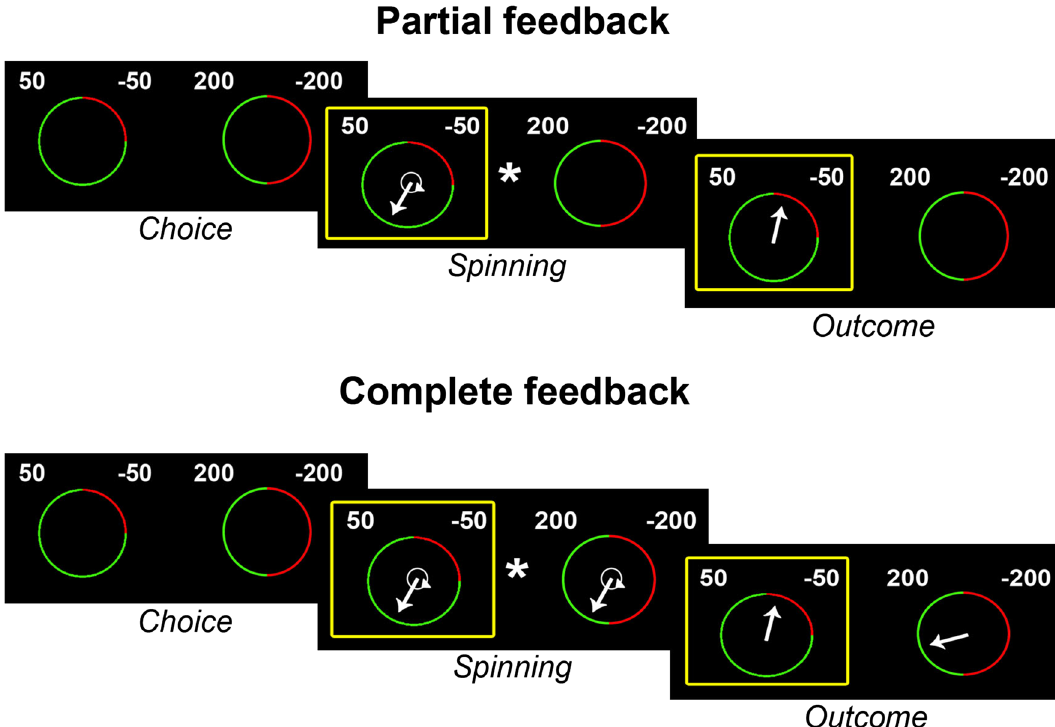
Figure 2. Wheel of fortune (WoF) task. Subjects are repeatedly asked to choose between two gambles, depicted as wheels of fortune associated with specific paired combinations of monetary outcomes (200, 50, − 50 and − 200) and levels of probability represented by the size of the green/red sectors (20–80, 50–50 and 80–20). The possible counterfactual combinations of wins and losses result in four potential levels of regret and relief (± 100, ± 150, ± 250 and ± 400) when subjects are shown the outcomes of both the selected and unselected gambles (CF). In the PF condition, instead, only the outcome of the selected gamble is shown, thus resulting in satisfaction or disappointment for the best or worse outcome. The gambles were shown for 4.5 s, during which subjects could evaluate them and make a decision. Next, the appearance of an asterisk in the centre of the screen prompted them to choose a gamble, which was highlighted by a yellow contour. Two seconds after the appearance of the asterisk a white arrow appeared in a random position in both wheels (CF) or only in the selected wheel (PF). One second later, the arrow(s) started spinning clock-wise, with different and random initial speed(s), and stopped after exactly 4 s, indicating the final outcome(s), that remained on the screen for 3